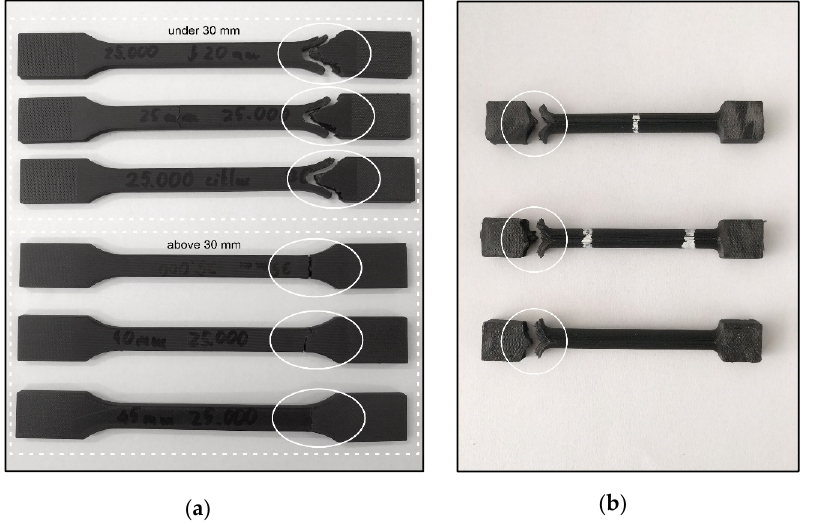
Figure 9. ( a ) Composite test specimens used in flexural fatigue testing, after performing the tensile strength test. The white circles indicate a “V”-like fracture pattern in the case of test specimens under 30-mm deflection; the white dotted frame represents the straight fracture line above a 30-mm deflection rate. ( b ) Composite test specimens used in torsion fatigue testing, after performing the tensile strength test. The white circles indicate the “V”-like fracture pattern.